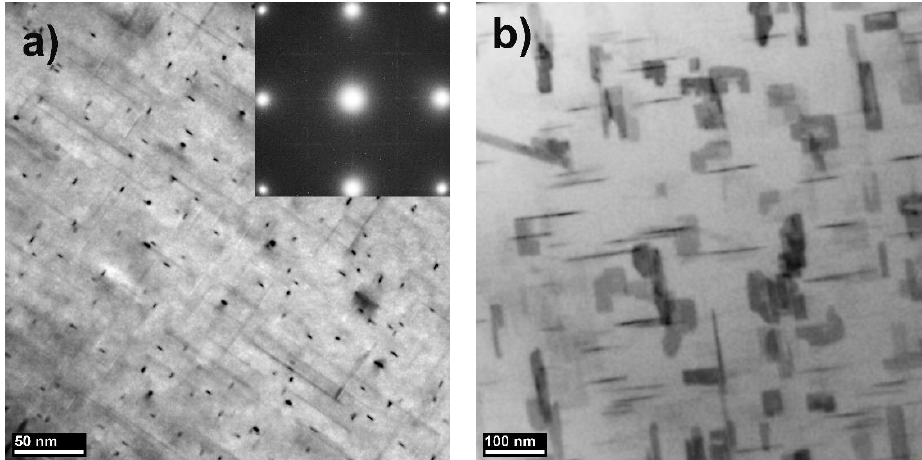
Figure 16. TEM micrographs of rheocast AlSi9Cu3(Fe) alloy after peak ageing treatment at 220 °C, acquired ( a ) close to <100> Al direction and the corresponding SAED pattern (inset) and ( b ) after specimen tilting to <110> Al direction.